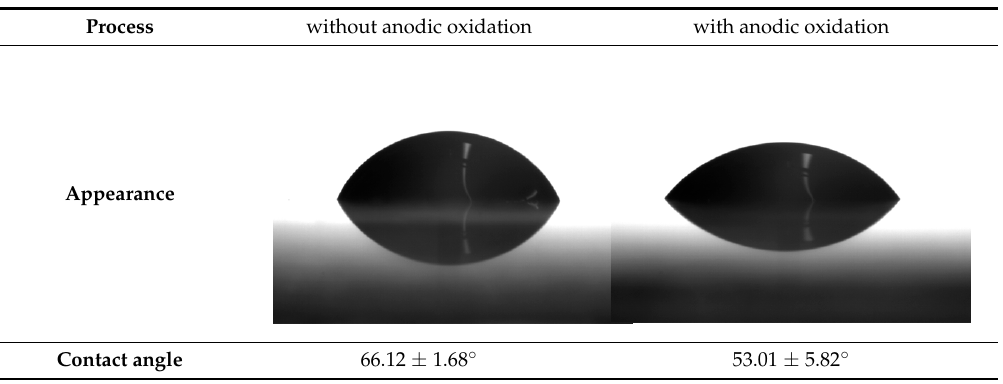
Table 1. Static magnetic nanofluid sessile droplet on aluminum surfaces.